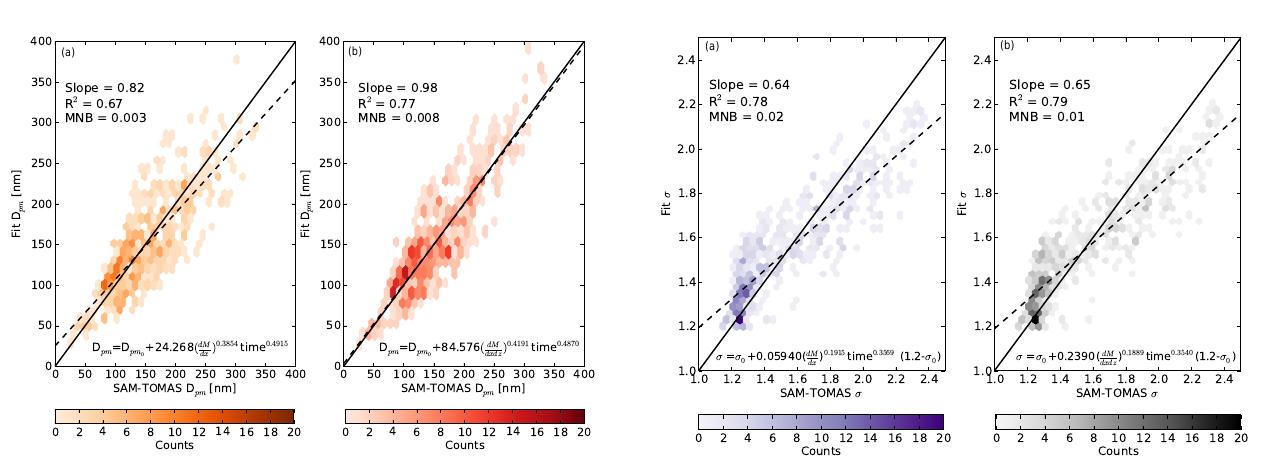
Figure 9. One-to-one plot showing simplified D pm fits vs. SAM- TOMAS for (a) d M/ d x and (b) d M/ d x d z . The black line is the one- to-one line. The dashed black line is the line of best fit. N = 624. Table 3. Best-fit parameters for the simplified D pm and σ SAM- TOMAS parameterizations (Eqs. 1–4).